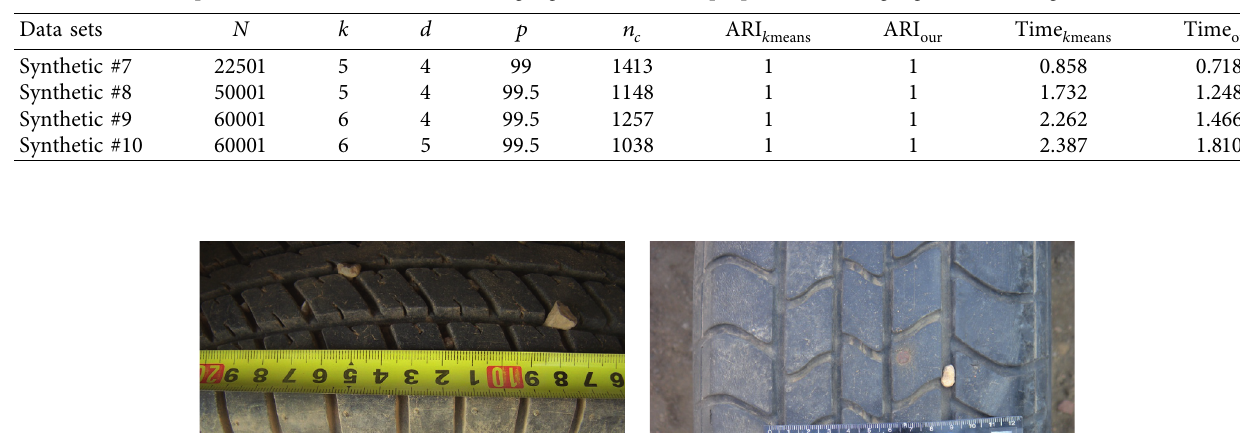
Table 2: Comparison between k -means clustering algorithm and our proposed clustering algorithm on large-scale data sets.